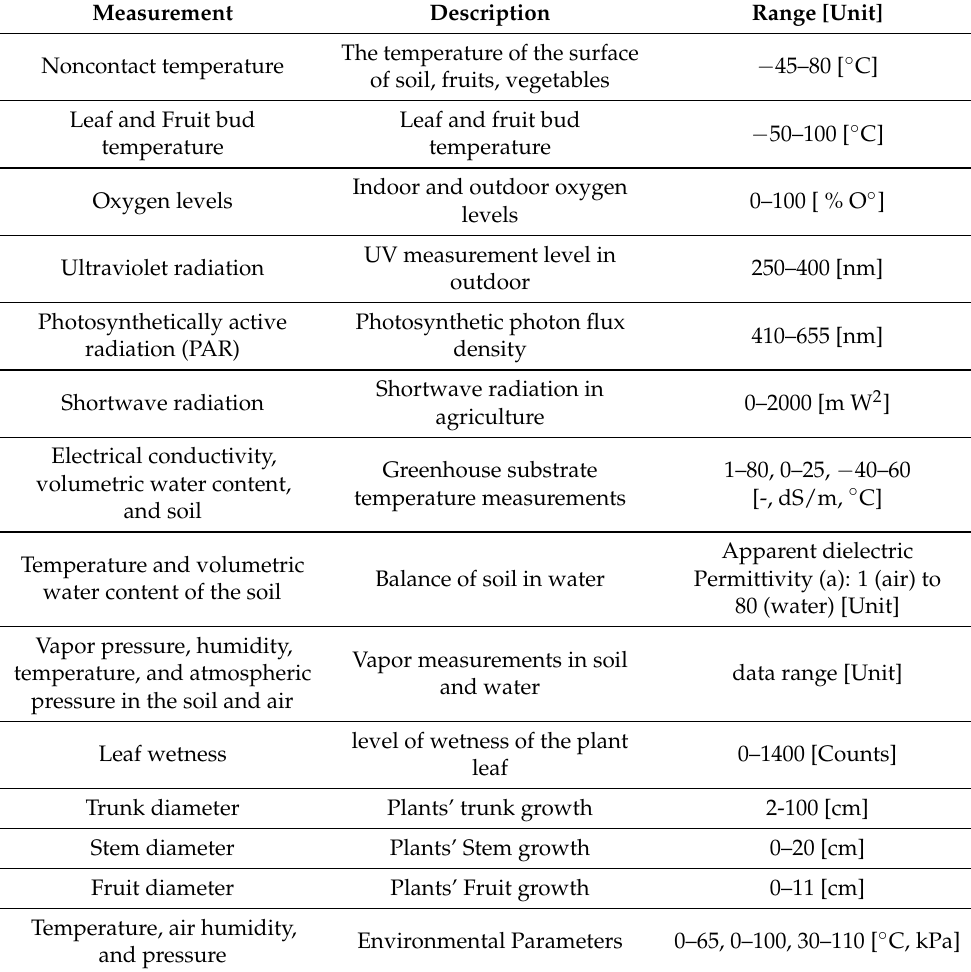
Table 1. Sensory Data used plant sensory data in precision agriculture.